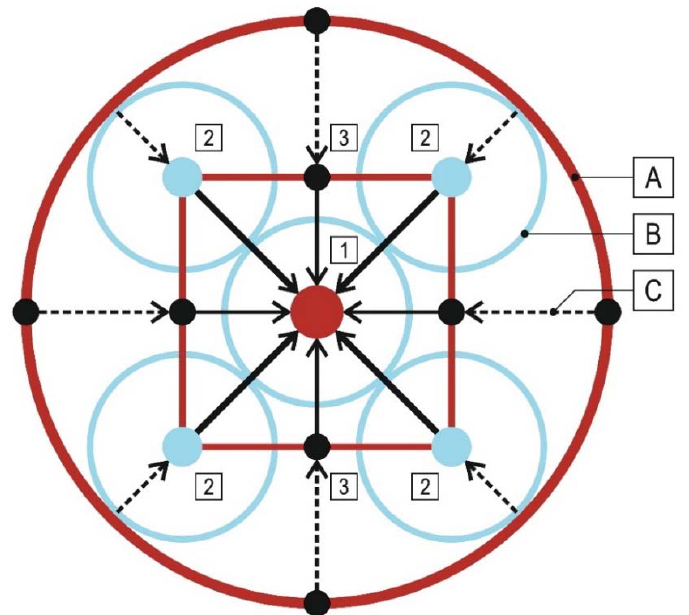
Figure 15. Combined educational trail model (scheme from the author). LEGEND: A—Regional circular educ. trail, B—Local educ. trail, C—Line educ. trail, 1—Regional center, 2—Local center, 3—Fragment of mining.